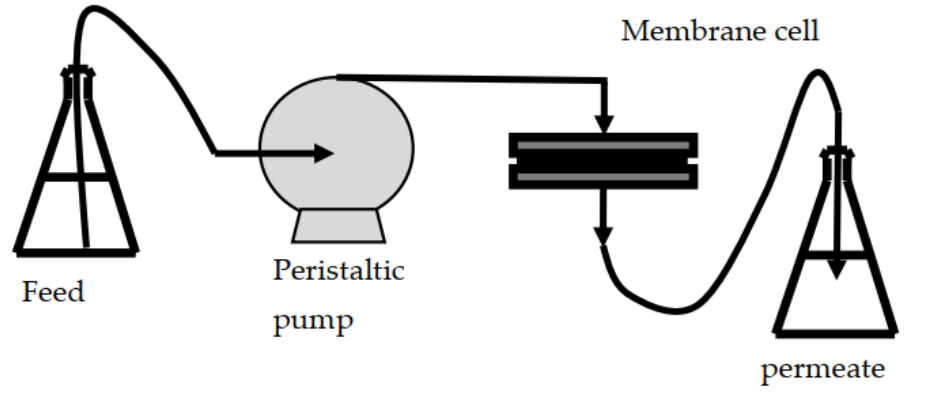
Figure 1. Schematic illustration of the setup.